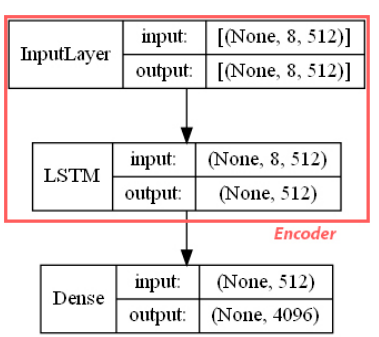
Figure A1. The feed-forward auto-encoder.